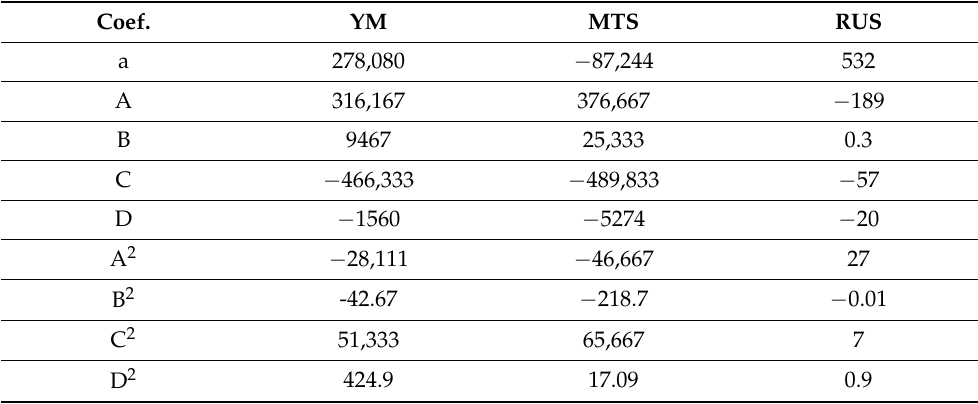
Table 4. Coefficients of 4-D surface responses of the YM, MTS and RUS.